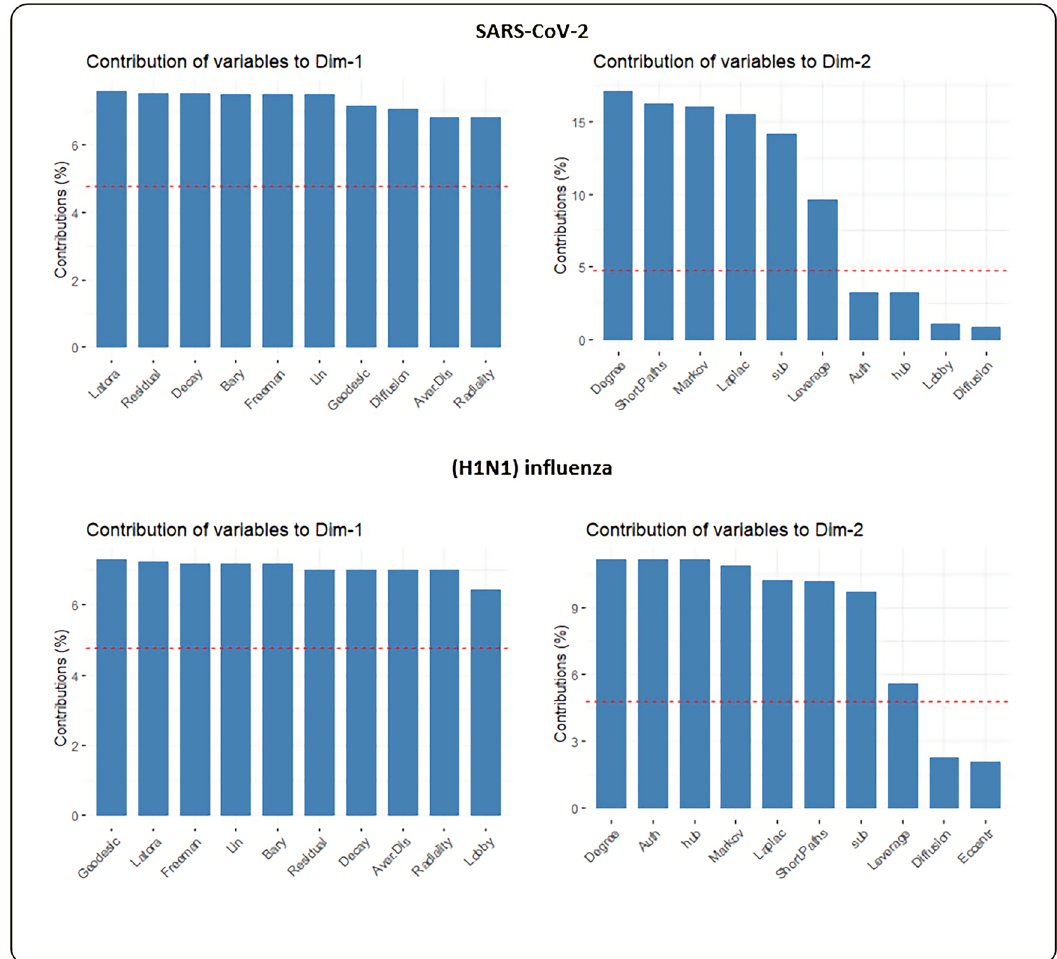
Figure 6. The top 10 centrality measures contributing to PCA for two dimensions.